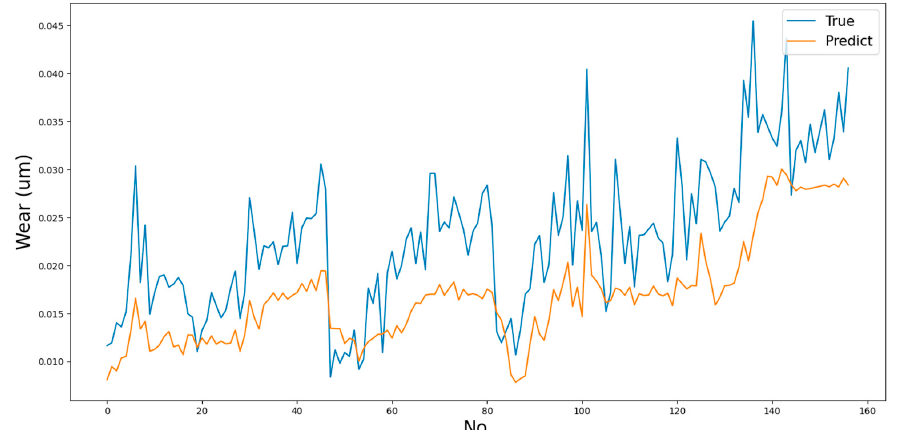
Figure 9. Prediction results with HPO.